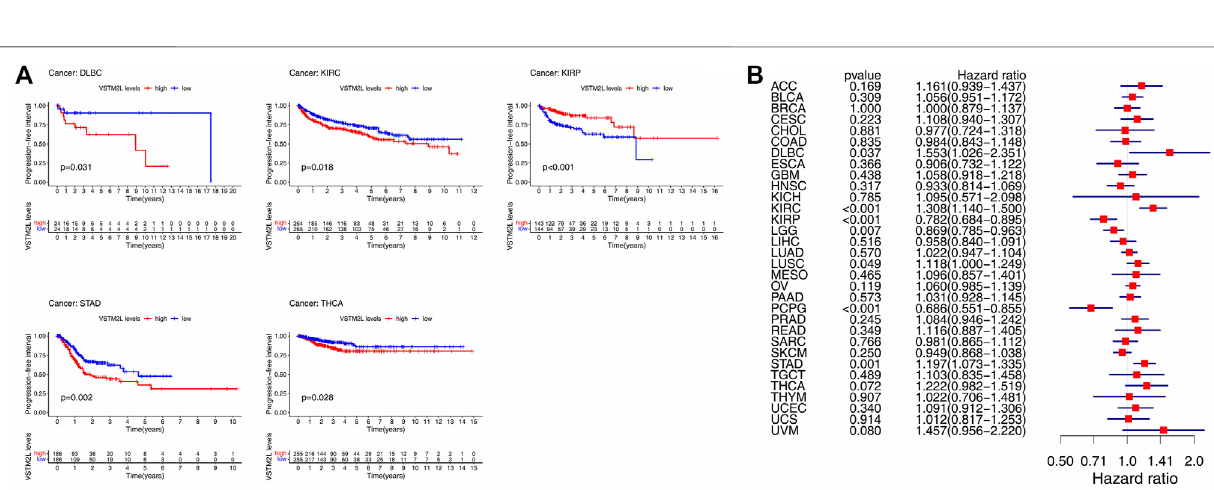
FIGURE 3 | Kaplan – Meier survival and Cox regression analyses of the prognostic value of VSTM2L expression level for DSS in different cancer types. (A) DSS accordingtohighandlow VSTM2L expressioninKIRC,KIRP,OV,PCPG,STAD,UCEC,andUVMfromTCGA. (B) Correlationbetween VSTM2L mRNAexpressionlevel and DSS in various cancer types. * p < .05.